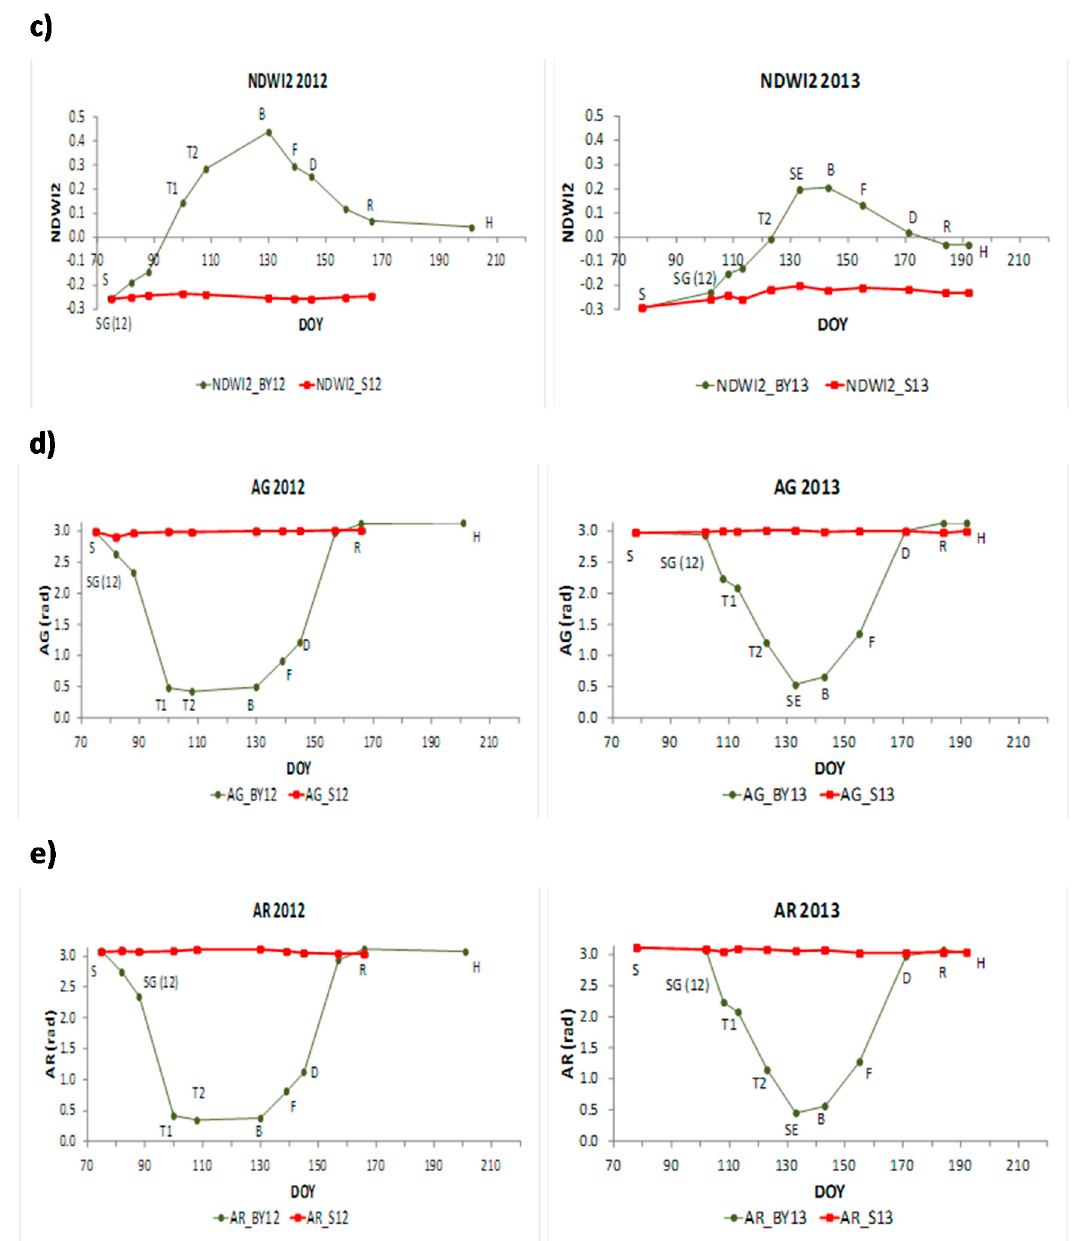
Figure 5. Spectral Sentinel-2 indices dynamics: ( a ) NDVI, ( b ) EVI, ( c ) NDWI2, ( d ) AG, ( e ) AR. Average values for the two barley plots (BY) and measured values for the bare soil plot (S) in 2012 and in 2013 in Madrid, Spain.